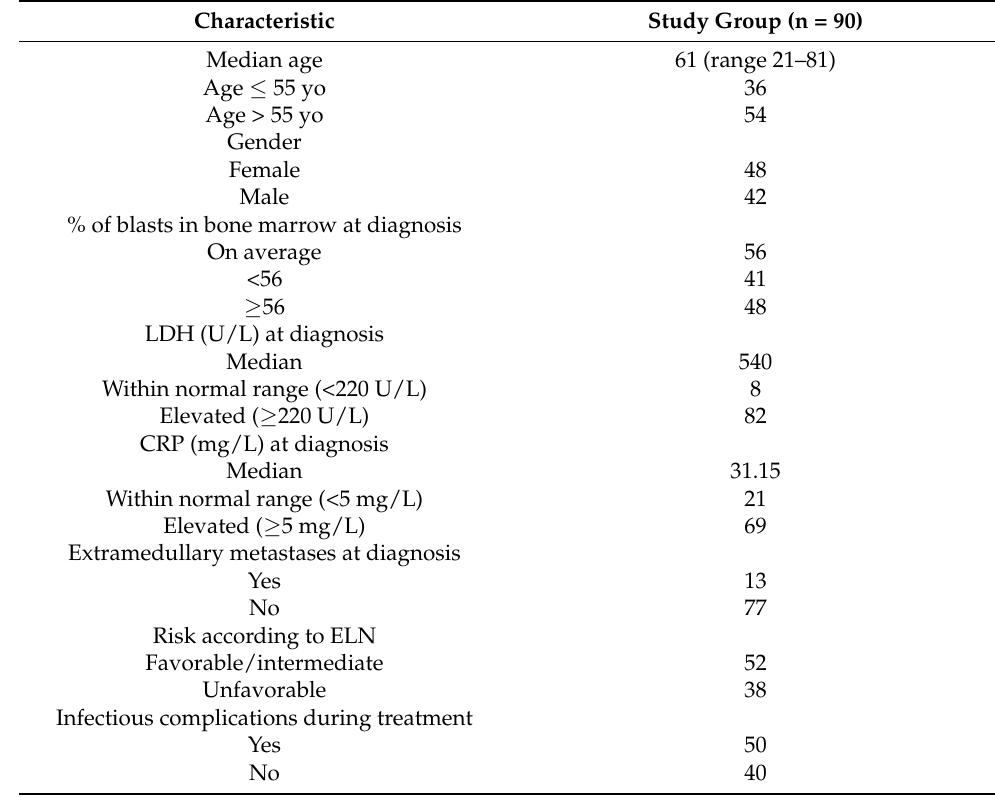
Table 2. Study group characteristics. LDH—lactate dehydrogenase, ELN—European Leukemia Net. Characteristic Study Group (n = 90) Median age 61 (range 21–81)